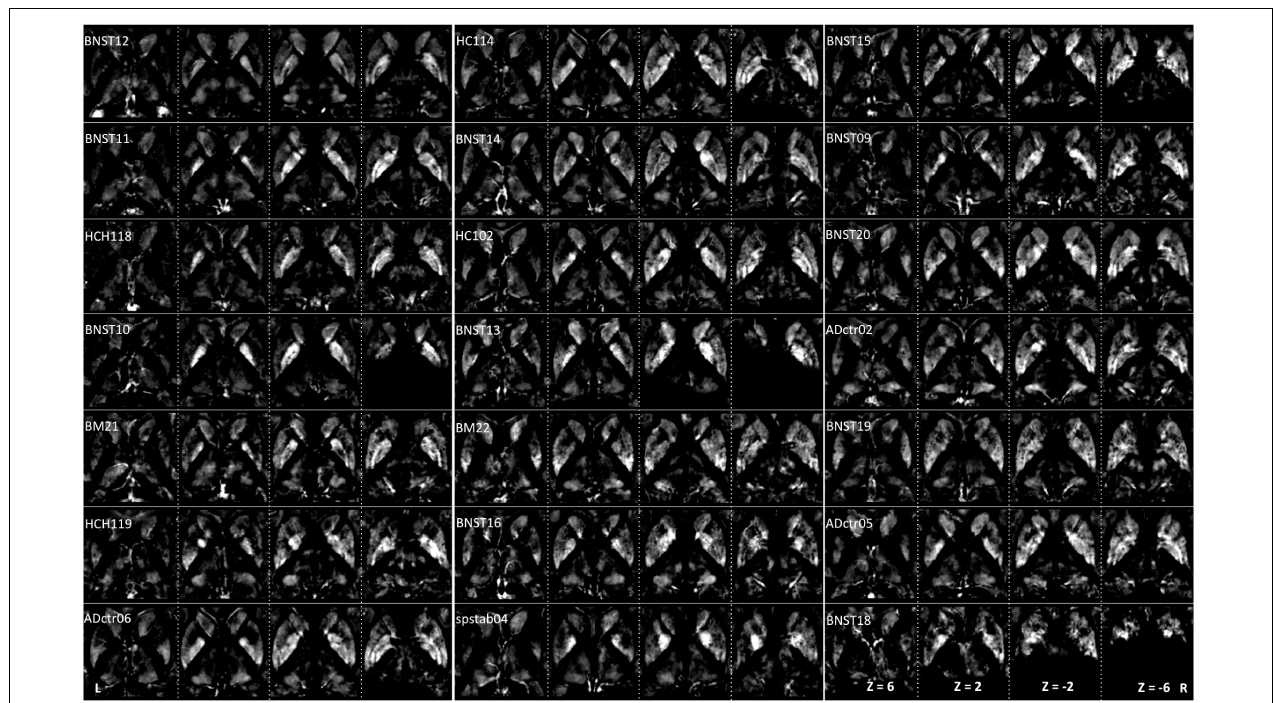
FIGURE 5 | Intervididual maps: QSM images of paramagnetic sources (iron, etc.) obtained from 21 subjects ordered with increasing age. The grayscale color code indicates brighter values in the highly myelinated structures. Note the highest values in the pallidum, caudate, at the specific sites in putamen and thalamus. Darker values indicate lower values. Three subjects (BNST10, BNST13, BNST18) show only partial